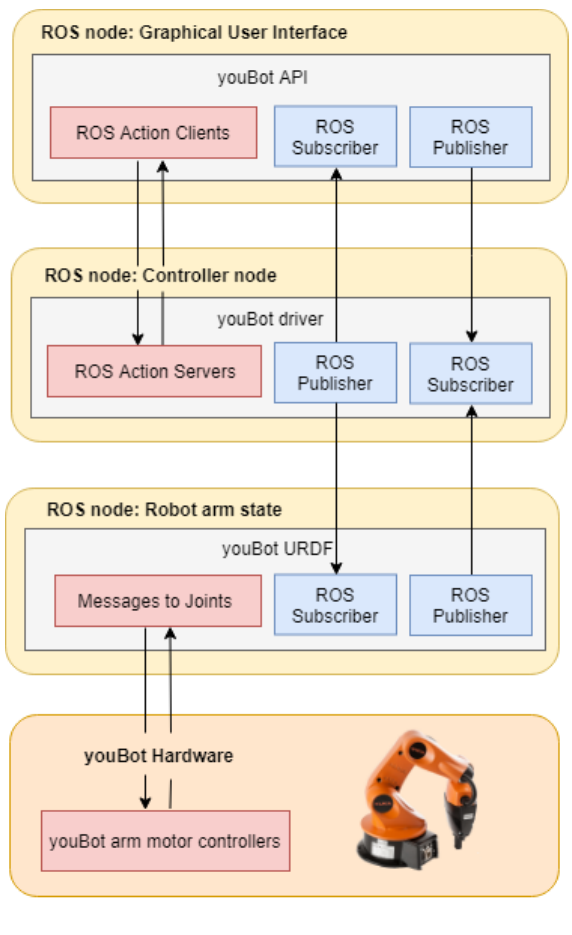
Figure 9. ROS node